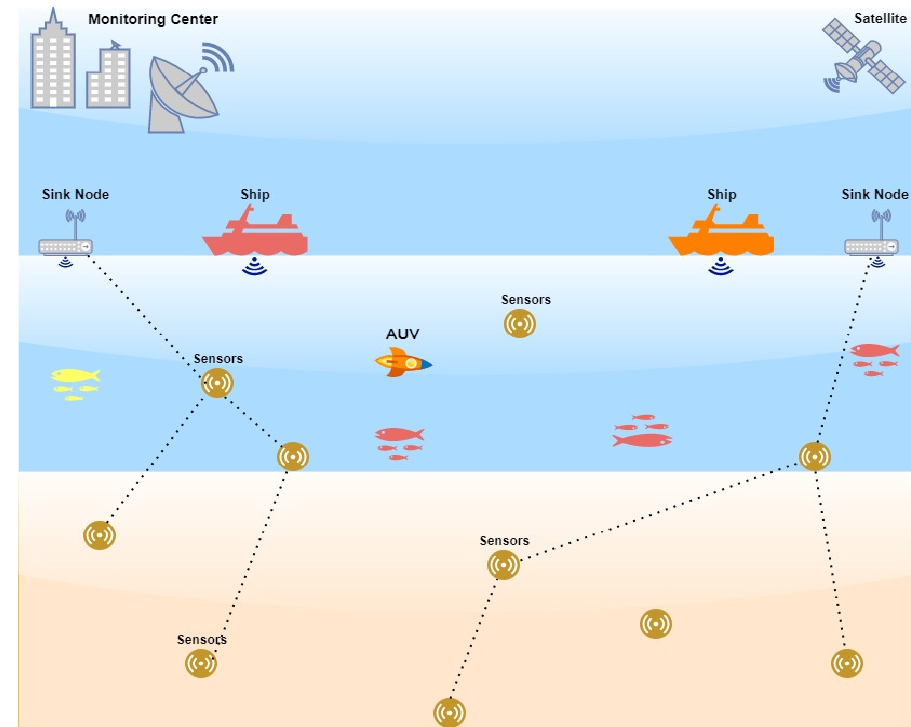
Figure 1. The basic structure of UWSNs.